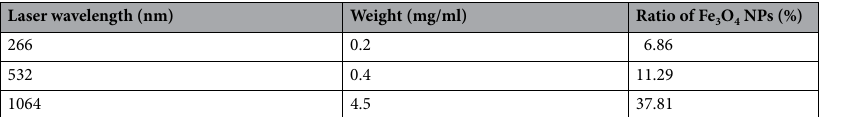
Laser wavelength